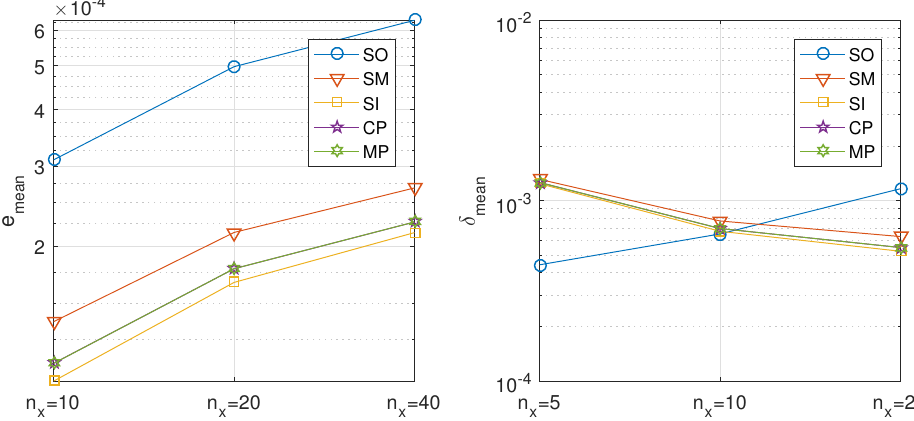
Figure 12. Mixed convection-diffusion and Burgers’ equation, convection-diffusion decomposition. Precision of the proposed methods: sequential iterative SI, classical parallel CP, and modern parallel MP, compared with the classical ones: sequential operator SO and Strang–Marchuk SM, for different number of spatial